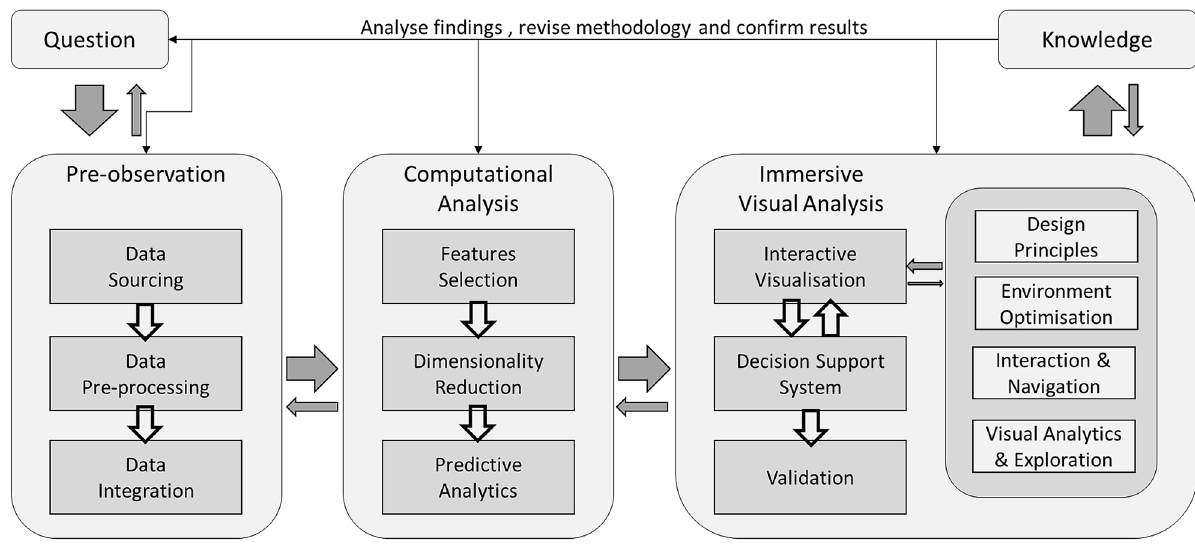
Figure 11. Our immersive visual analytics of genomic data for cancer patients extends Nguyen et al. 33